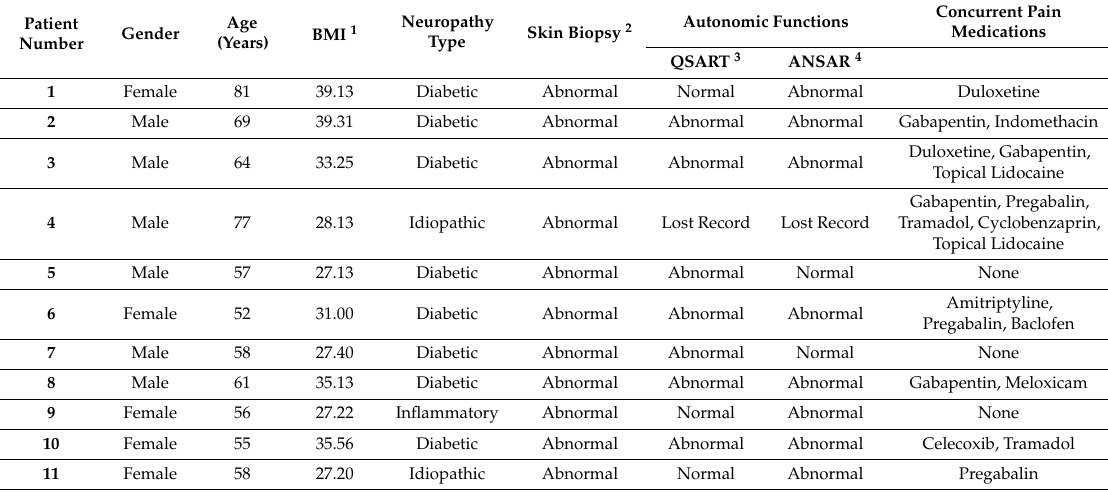
Table 1. Baseline demographic parameters and clinical